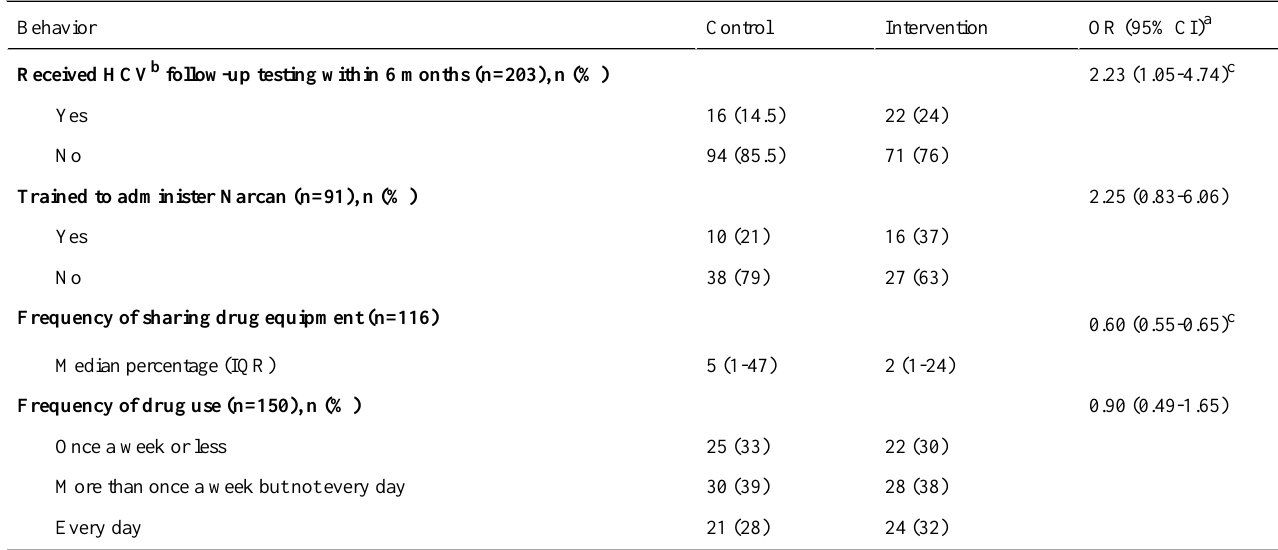
Table 2. Proportion who received Hepatitis C virus testing and underwent Narcan training, and the frequency of sharing drug equipment and using drugs at